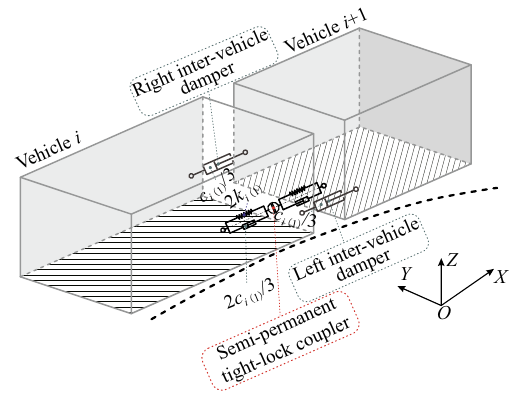
Fig. 1 Adjacent vehicles of a high-speed train joined via the advanced